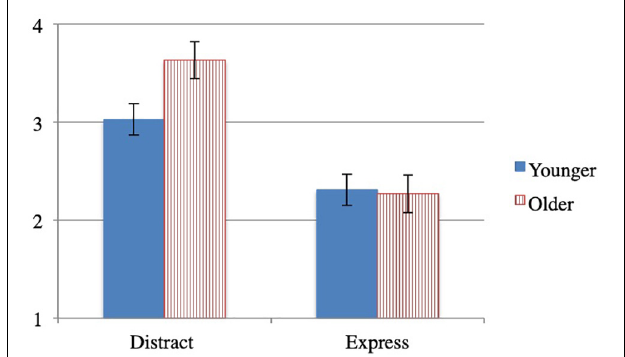
FIGURE 1 | Study 1 mean absorption by condition and age group.